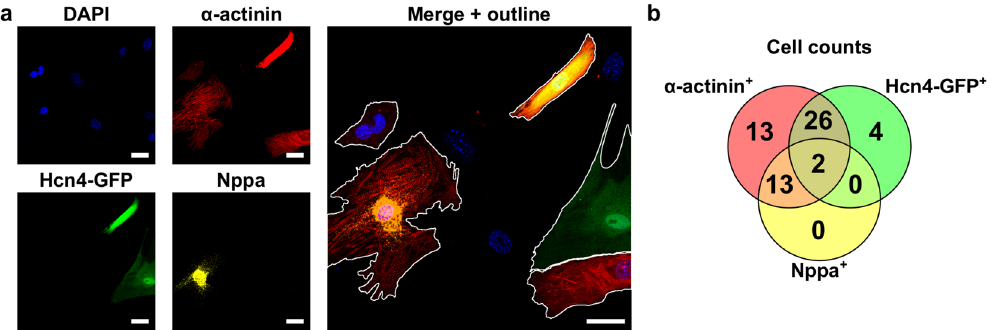
Figure 1. Automated cell segmentation identifies induced cardiac-like myocytes (iCLMs) with heterogeneous marker expression. ( a ) Mouse embryonic fibroblasts were isolated from E13.5 mouse embryos and reprogrammed by transfecting with retroviral constructs of GHMT. Cells were examined by immunofluorescence for expression of cardiac markers α -actinin, Hcn4-GFP, and Nppa. The merged image is shown on right with automated cell segmentation outlines in white. Scale bar = 20 μ m. ( b ) Venn